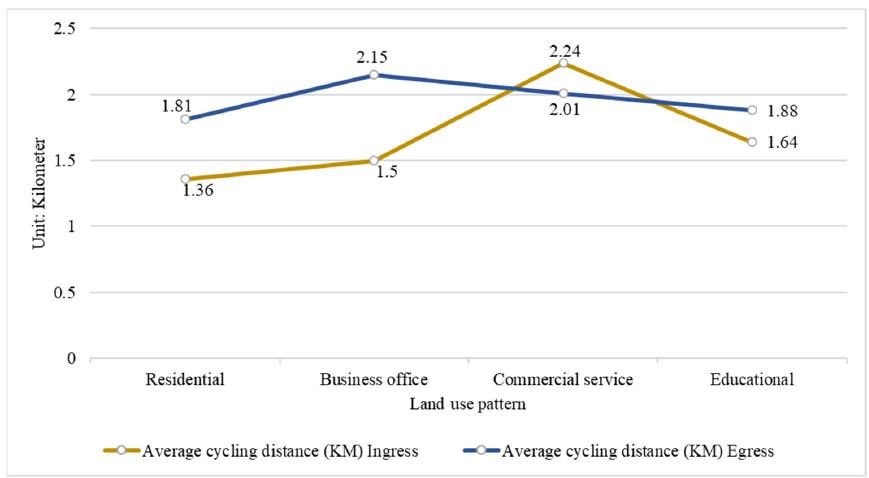
Figure 18. Cycling statistics of main land use patterns.